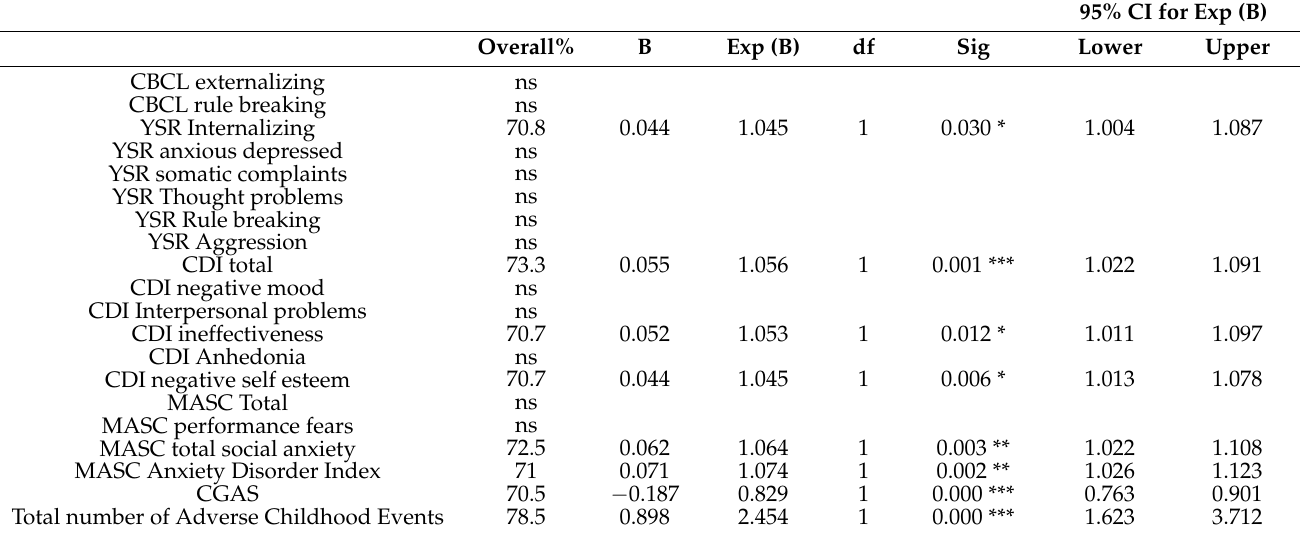
Table 5. Univariate Logistic